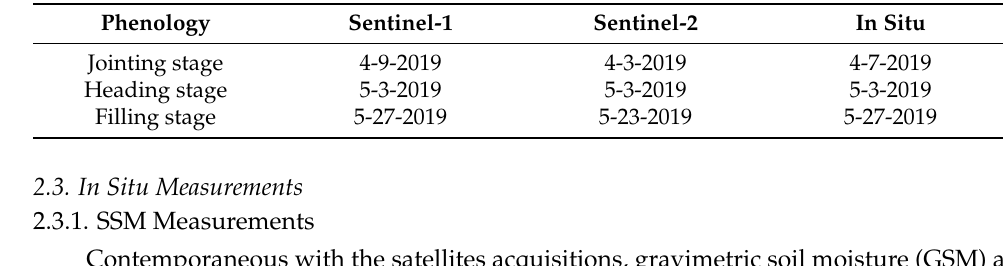
Table 1. List of satellite-based and in situ data used over the study